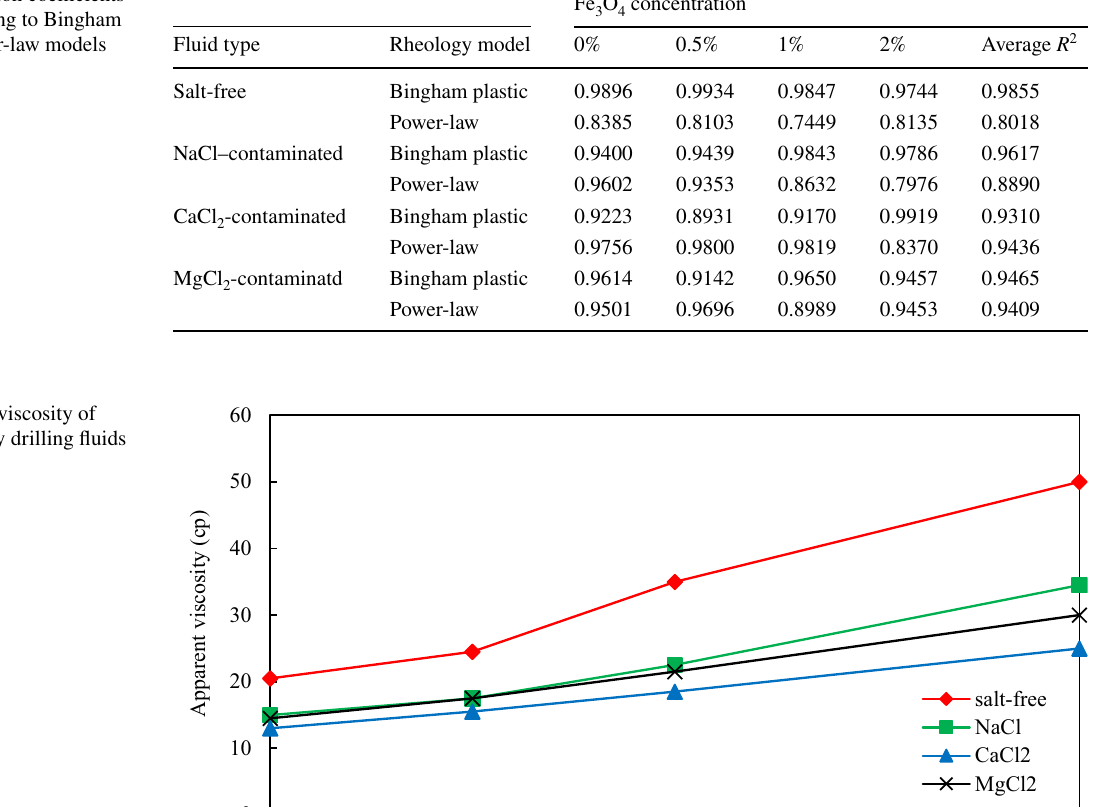
( R 2 ) corresponding to Bingham plastic and power-law models for all the fluids